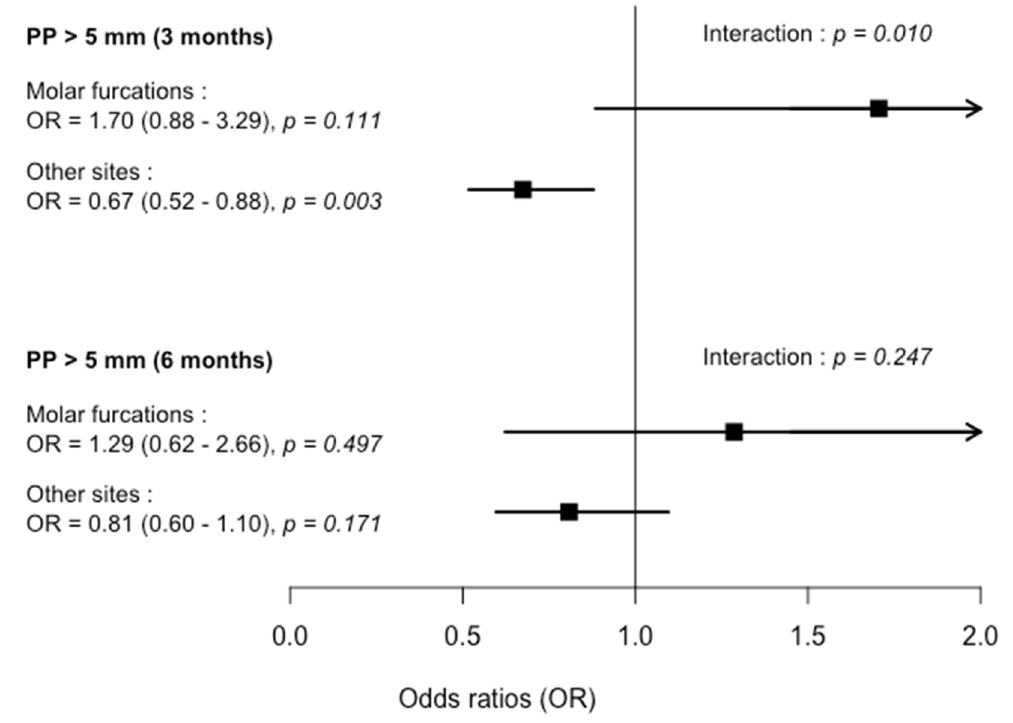
Figure1. ComparisonofOR.Horizontallinesrepresent95%ofconfidenceinterval.